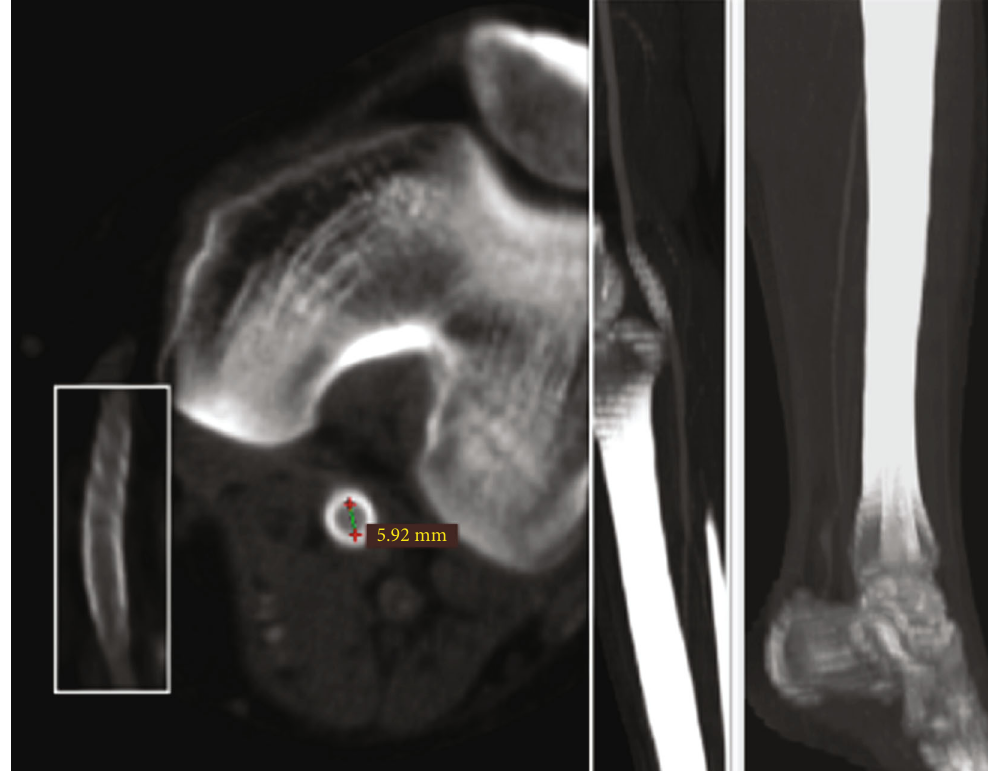
Figure 4: Follow-up CT angiography: complete exclusion of the aneurism and preserved patency of the posterior tibial